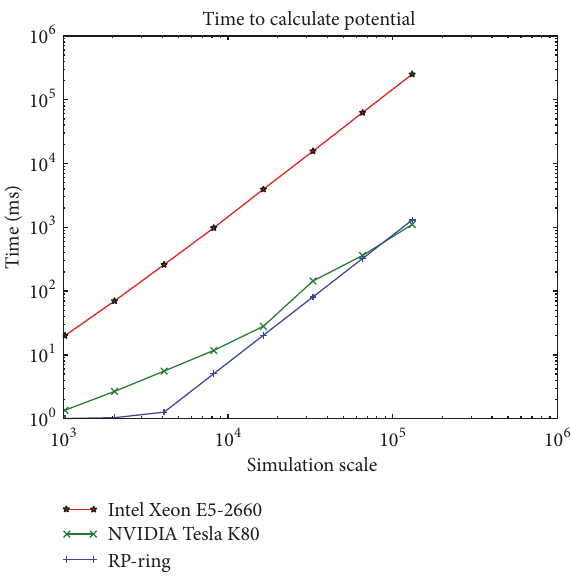
Figure 14: Software performance comparison. Table 3: Communication bandwidth consumption.